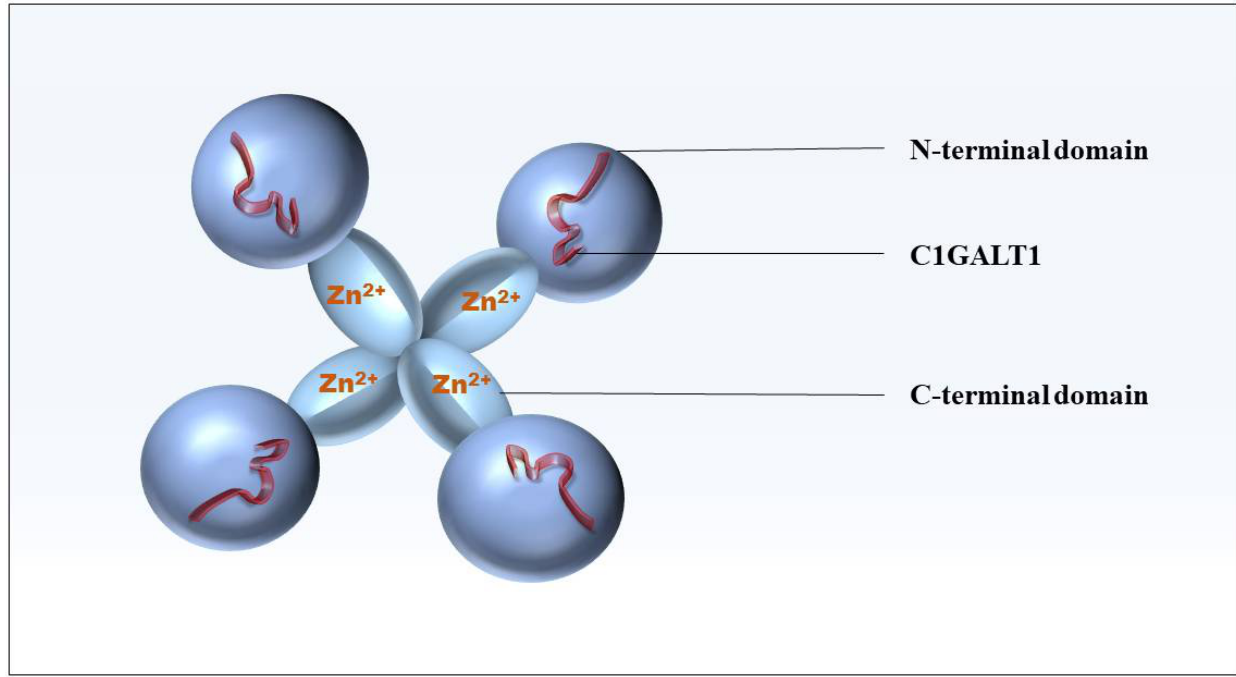
Figure 2. Model of Cosmc structure. The N-terminal domain of Cosmc (dark blue) is responsible for interacting with C1GALT1 (red peptide) for chaperone function, and the C-terminal domain (light blue) mediates oligomerization and Zn 2+ binding.